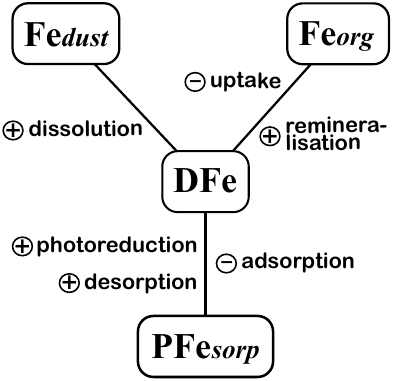
Fig. 2. Chemical model of iron. Processes supplying DFe haven a sign of + and those removing DFe a sign of −